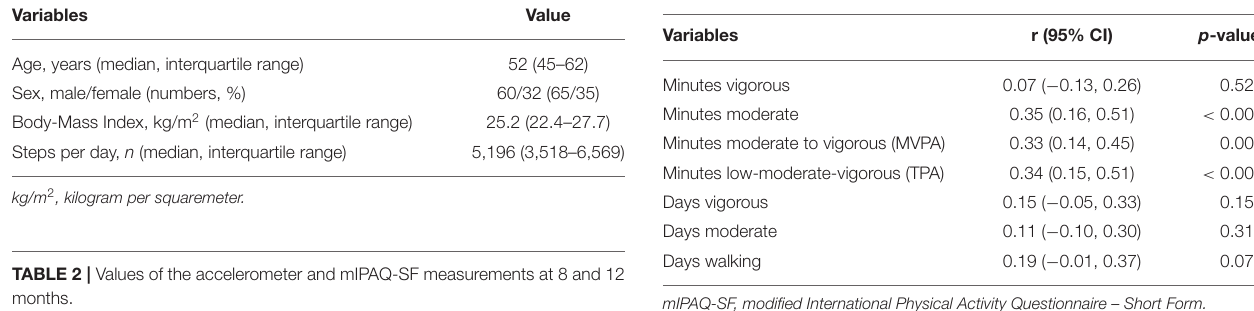
TABLE 3 | Pearson correlation coefficient table for validity between accelerometry and the